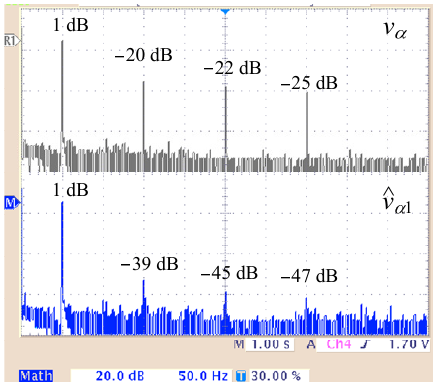
Figure 9. The fast Fourier transform (FFT) of the proposed SOHO-based FLL at f 0 = 50 Hz of: ( top ) the reference v α , and ( bottom ) the estimate ˆ v α ,1 ( x -axis: 50 Hz/div; y -axis: 20